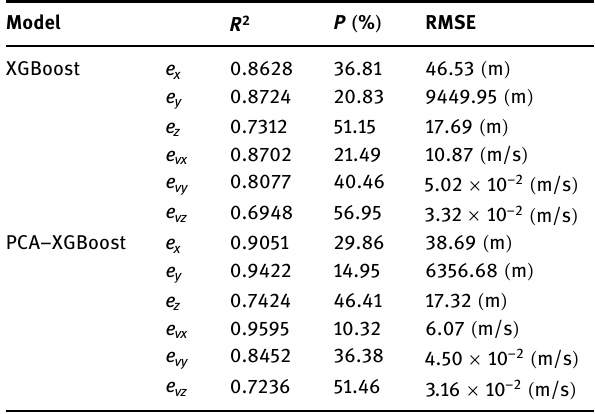
Table 7: Results of XGBoost model and PCA – XGBoost model for the testing dataset